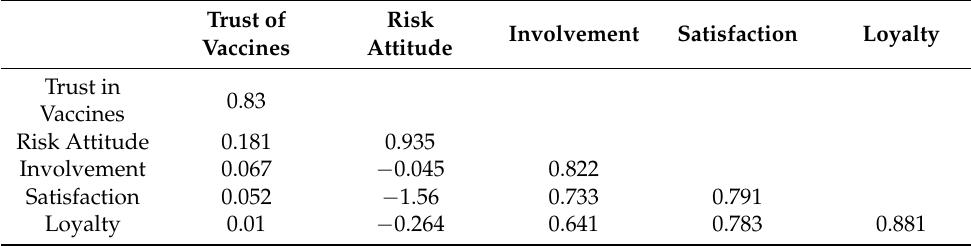
Table 4. Fornell-Larcker criterion.